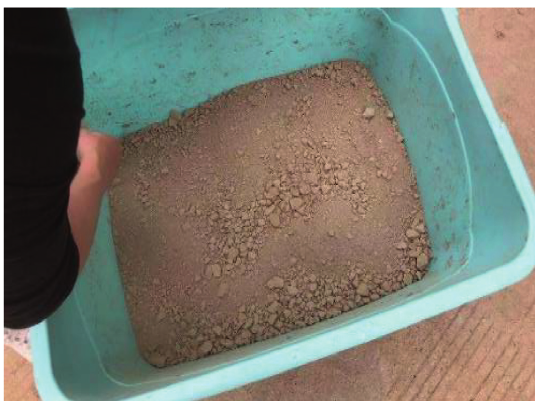
Figure 8: Making granular remolded